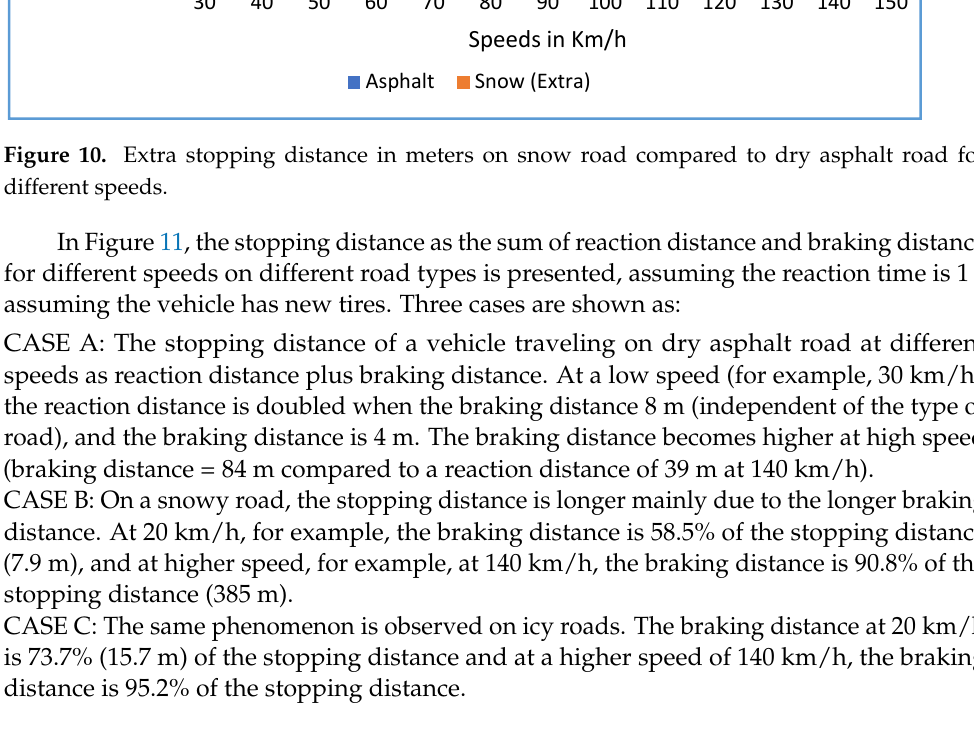
Figure 10. Extra stopping distance in meters on snow road compared to dry asphalt road for differ- ent speeds.